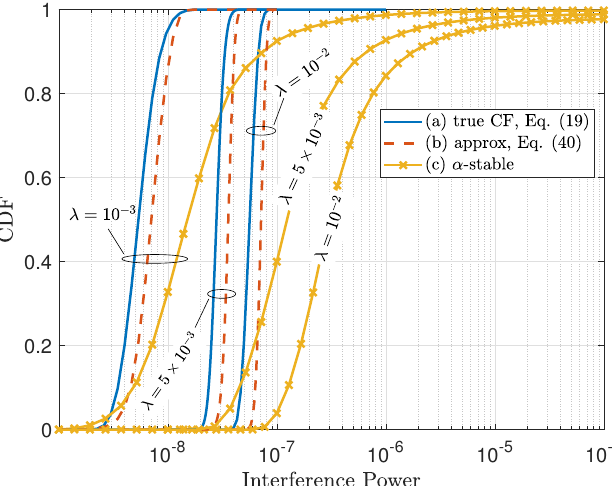
Figure 13. Comparison of the CDF of the aggregated interference power, within R max = 400 m using a UCA of size N c = 16 positioned at AP height h = 30 m, for different interferer density λ = { 1,5,10 } × 10 − 3 m − 2 , path-loss exponent 2 b = 2.6, transmit power [ P tx ] dBm = 20 dBm, central √ P tx 4 π F c / c , for three cases: (a) true CF model described in (19); frequency F c = 28 GHz and | β o | = (b) approximate mixture model described in (40); and (c) α -stable